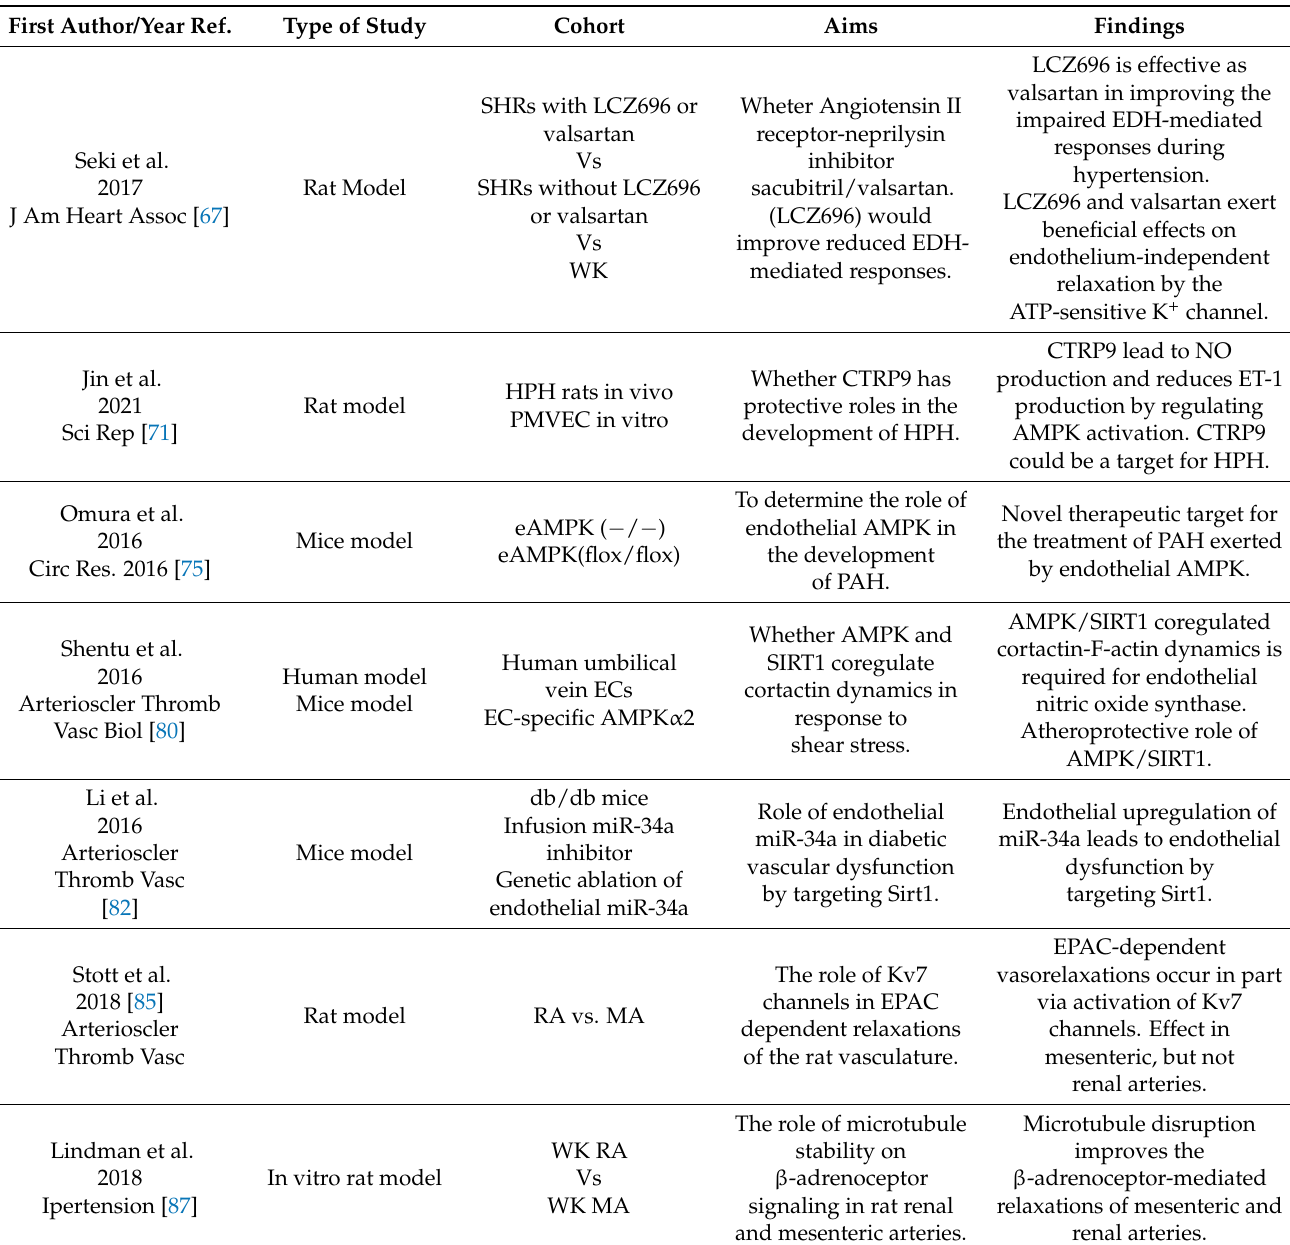
Table 3. Most recent pivotal studies on vascular dysfunction and identifying the role of AMP- activated protein kinase, potassium channels, bone morphogenetic protein 4 and P2Y2 receptor. The references represent the progression in the text according to those reported in the PRISMA